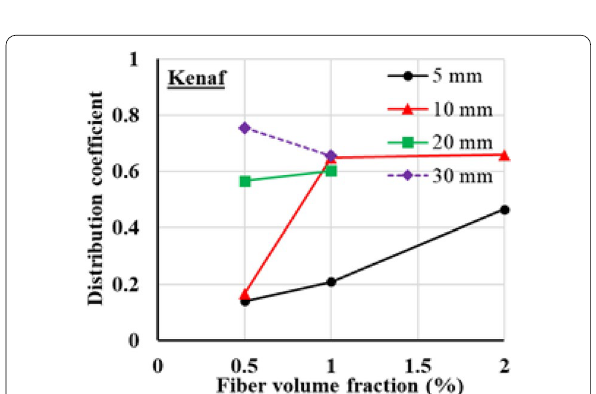
Fig. 18 Distribution coefficient versus volume fraction of kenaf fibers of different lengths